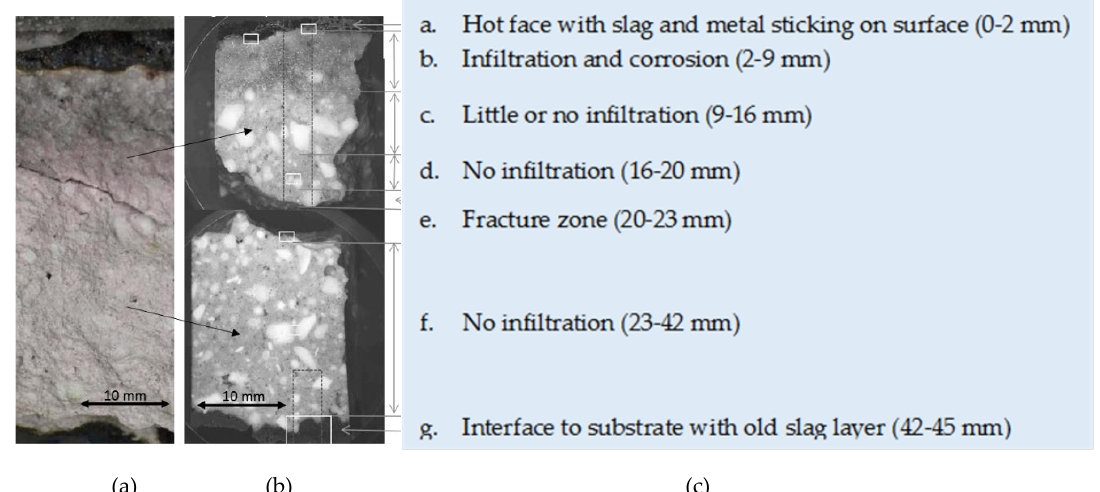
Figure 7. Postmortem sample of MagA-gun after 31 heats before ( a ) and after cutting ( b ) and macroscopic observations ( c ).